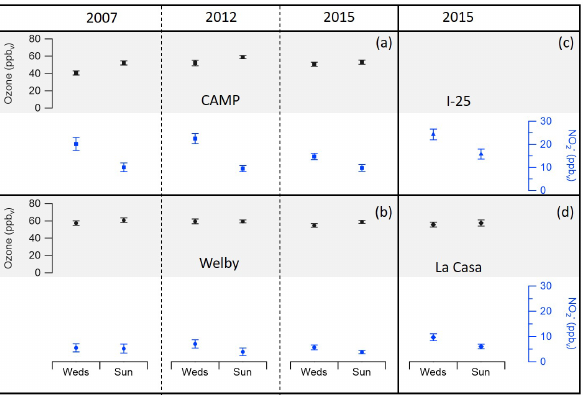
Figure 5. Weekend–weekday analysis (Sunday vs. Wednesday) for O 3 (black with shading) and NO ∗ (blue) for the CAMP ( a , squares), 2 Welby ( b , circles), and La Casa ( c , diamonds) sites in Denver. I-25 ( d , triangles) is limited to NO ∗ due to data availability. All sites have Figure 6. Weekday and weekend O 3 versus NO ∗ for Welby (black) 2 2 plots for 2015, but only CAMP (a) and Welby (b) are additionally and CAMP (blue) sites. Tethered symbols correspond to average plotted for 2007 and 2012 due to data availability. Wednesday is Wednesday values for weekdays and average Sunday values for representative of weekday NO ∗ and typically is not different than weekends for each year depending on data availability. The color 2 the average of Tuesday, Wednesday, and Thursday at a 95% confi- shading corresponds to year, with the lightest shade corresponding dence for this dataset. Monday, Friday, and Saturday are considered to the earliest year (2000 for Welby, 2005 for CAMP) and 2015 as carryover or “mixed” days between weekdays and weekends and the darkest shade. The 95% confidence intervals for each year are are ignored. Error bars represent 95% confidence intervals around <5ppb v for O 3 and <2.5ppbv for NO ∗ . The dashed blue line is a 2 the summertime mean of Wednesday or Sunday O 3 or NO ∗ . visual aid to guide the reader’s eye to the nonlinear O 3 curve and 2 was generated from the simple analytic model described by Farmer et al.